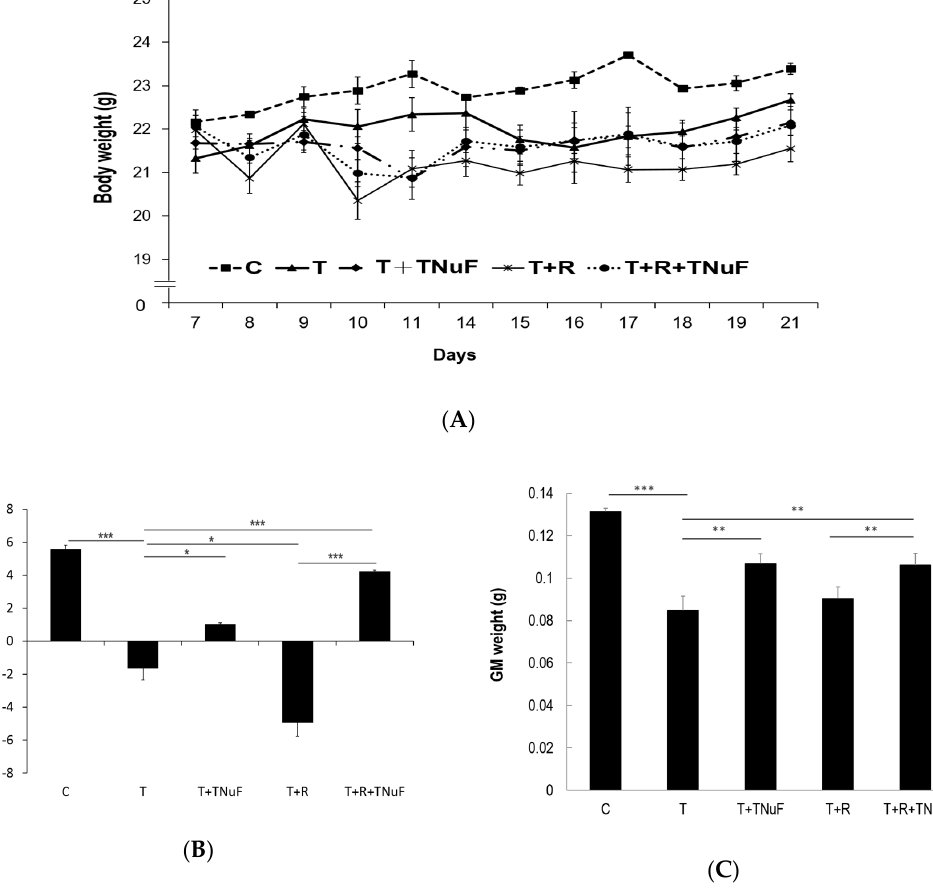
Figure 3. The cachectic symptoms after treatment of TNuF and / or irradiation in Lewis lung carcinoma (LLC) bearing mice. ( A ) The body weights of tumor-bearing nude mice with the treatments during the course. ( B ) Body-weight gain and ( C ) gastrocnemius medialis (GM) muscles mass for the mice in due course. Data were derived from three independent experiments and presented by mean ± SEM. * p < 0.05, ** p < 0.01, *** p < 0.001 when compared to the indicated group.